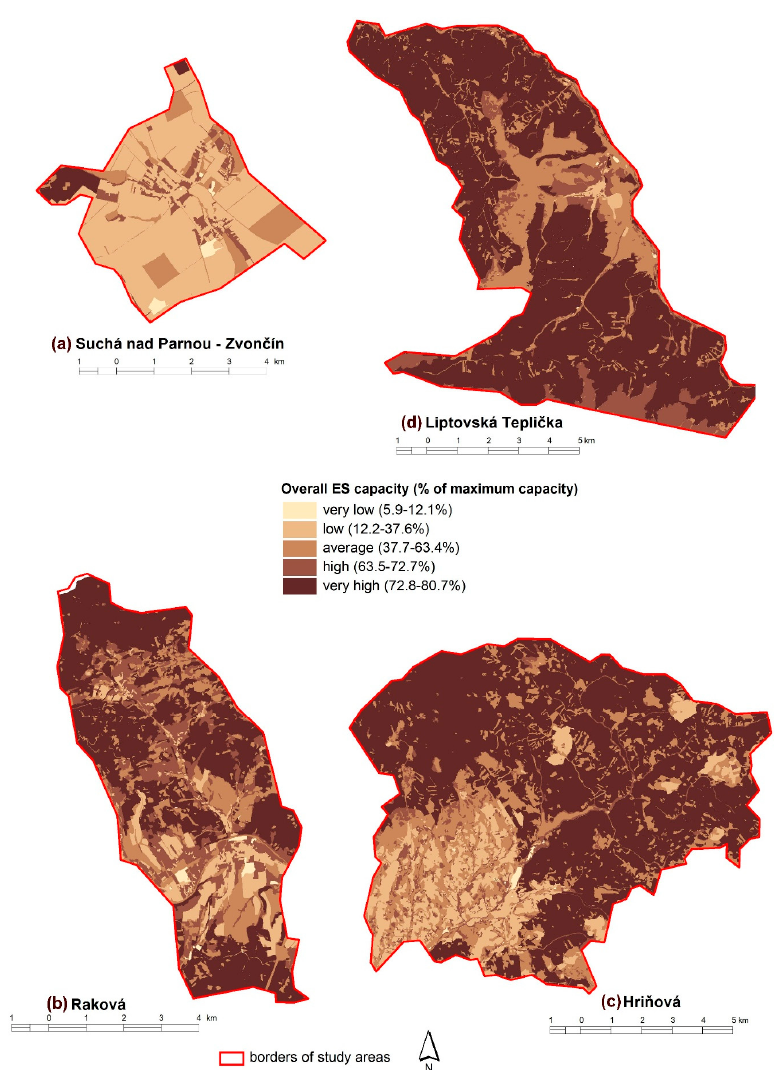
Figure 5. Overall territorial capacity for all ES based on values from experts’ judgment. ( a ) Suchá nad Parnou, ( b ) Raková, ( c ) Hri ň ová, ( d ) LiptovskáTepli č ka